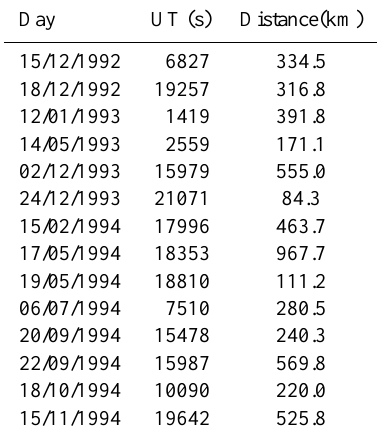
Table 3. List of days for data comparison